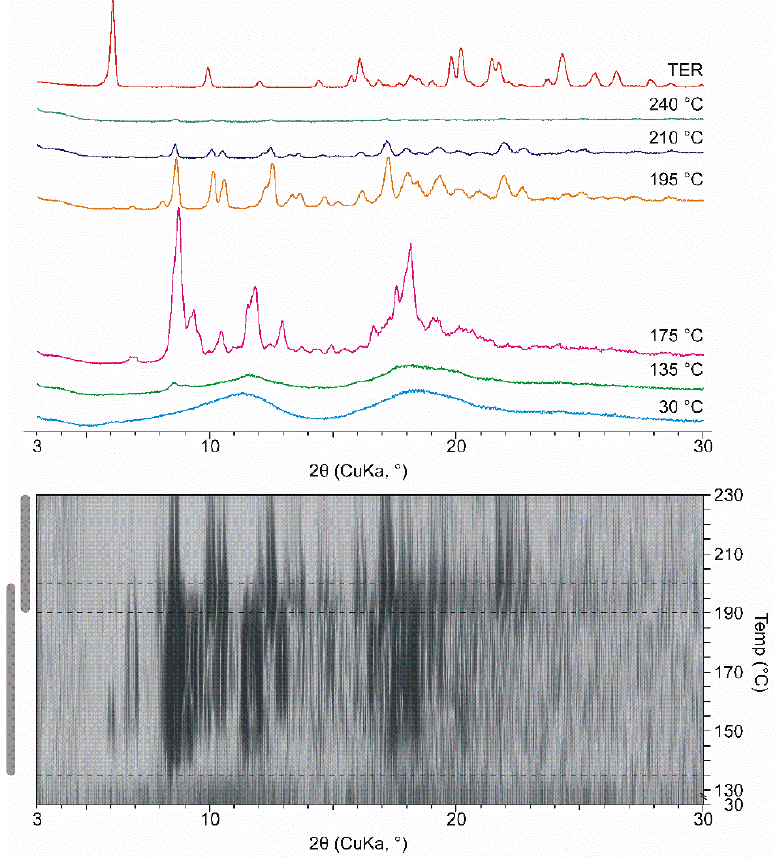
Figure 4. XRPD diffractograms were measured in various temperatures in the case of DIMEB product with 2D visualization. 2D visualization shows the temperature range and overlap of the two recrystallization phases.